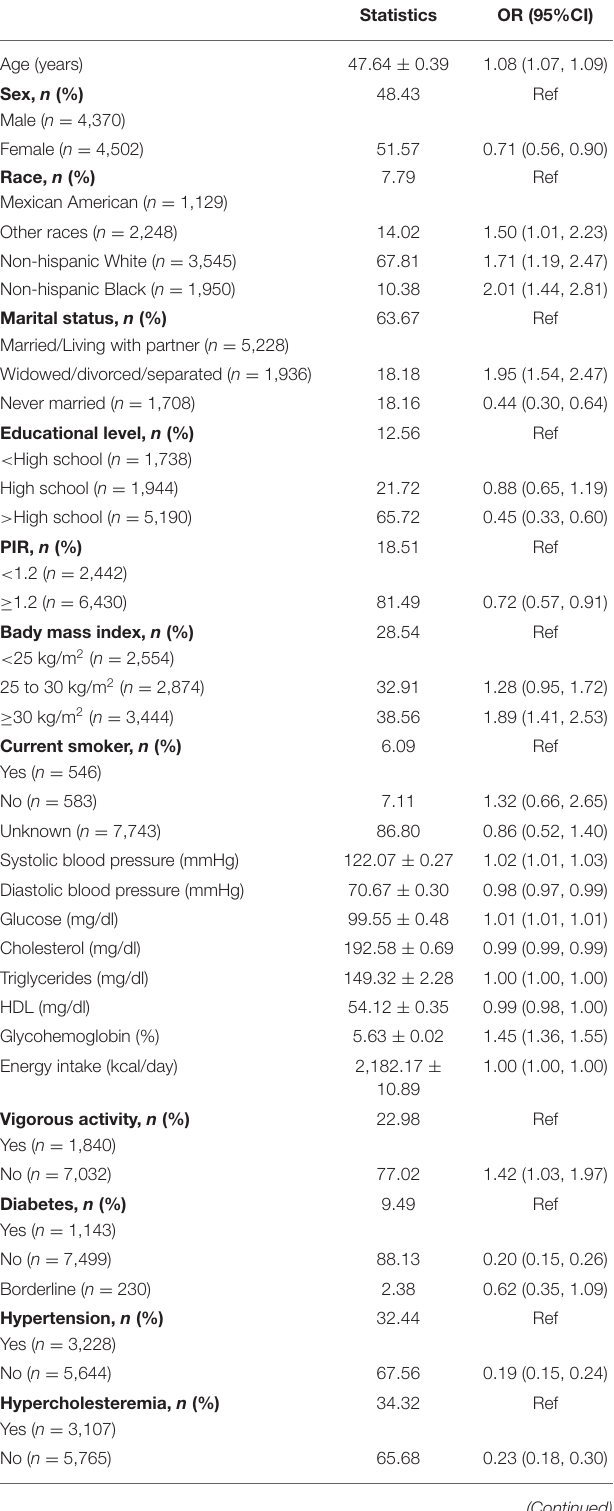
TABLE 2 | Results of the univariate logistic regression analysis of factors associated with nonfatal cardiovascular/cerebrovascular events, weighted.